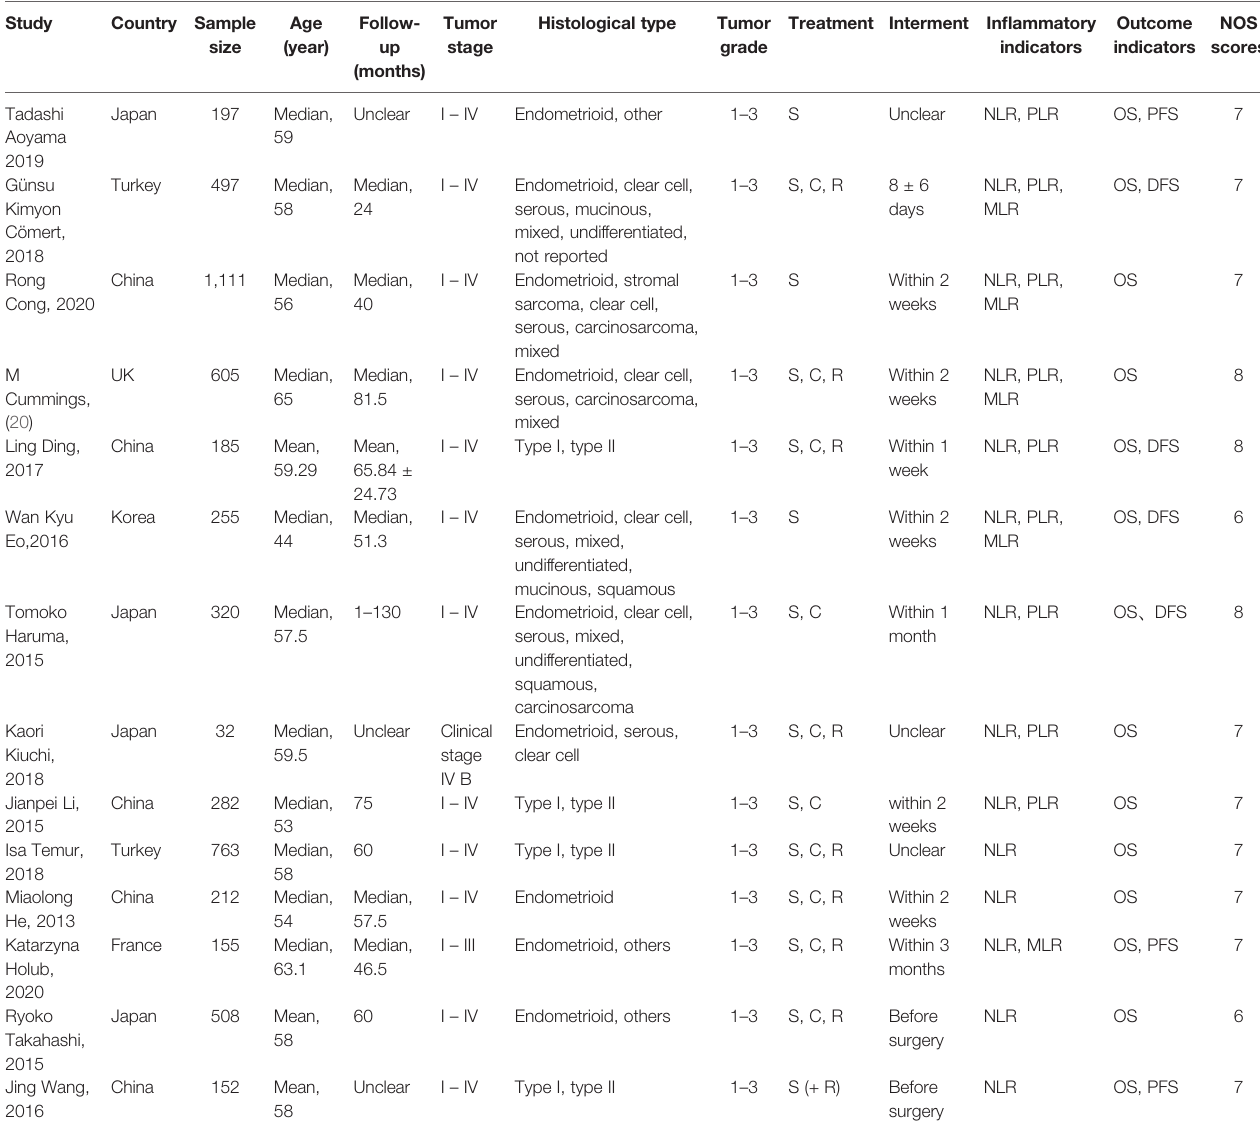
TABLE 1 | Characteristics of the included